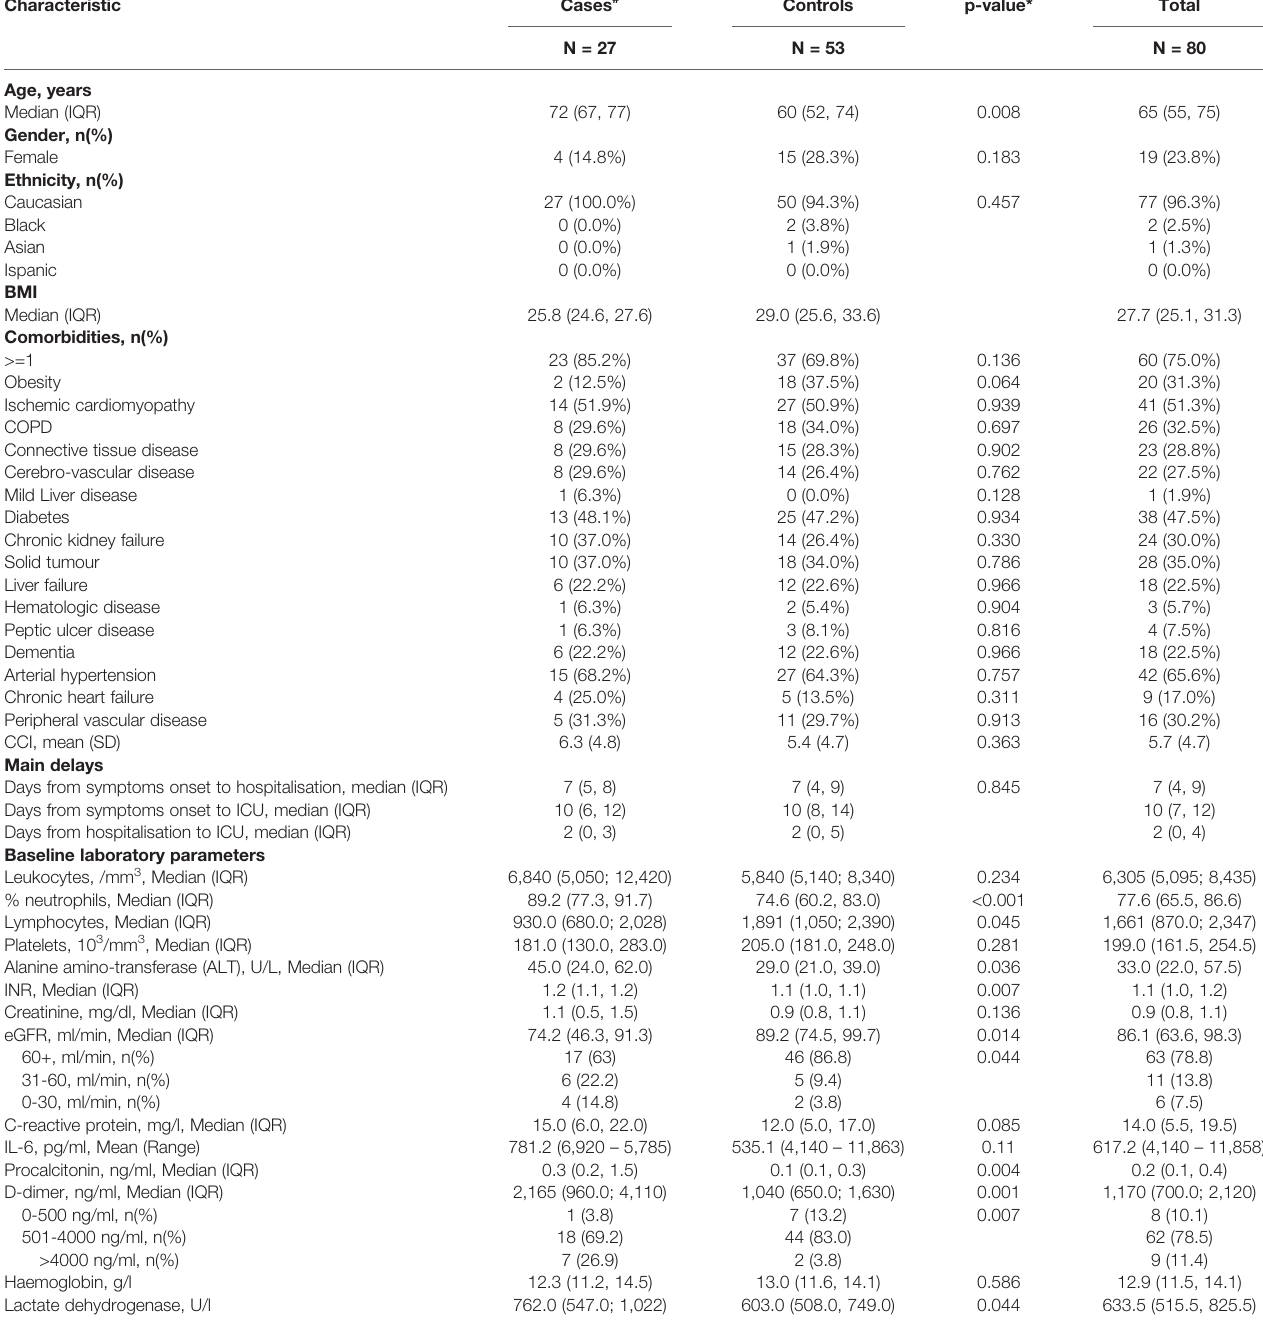
TABLE 1 | Demographic, clinical characteristics and baseline laboratory parameters of patients involved in the case-control study. Characteristic Cases #